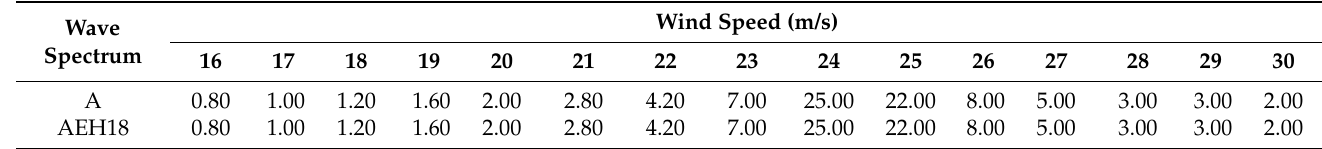
Table 5. The ζ values at different wind speeds under incidence angle of 50 ◦ .